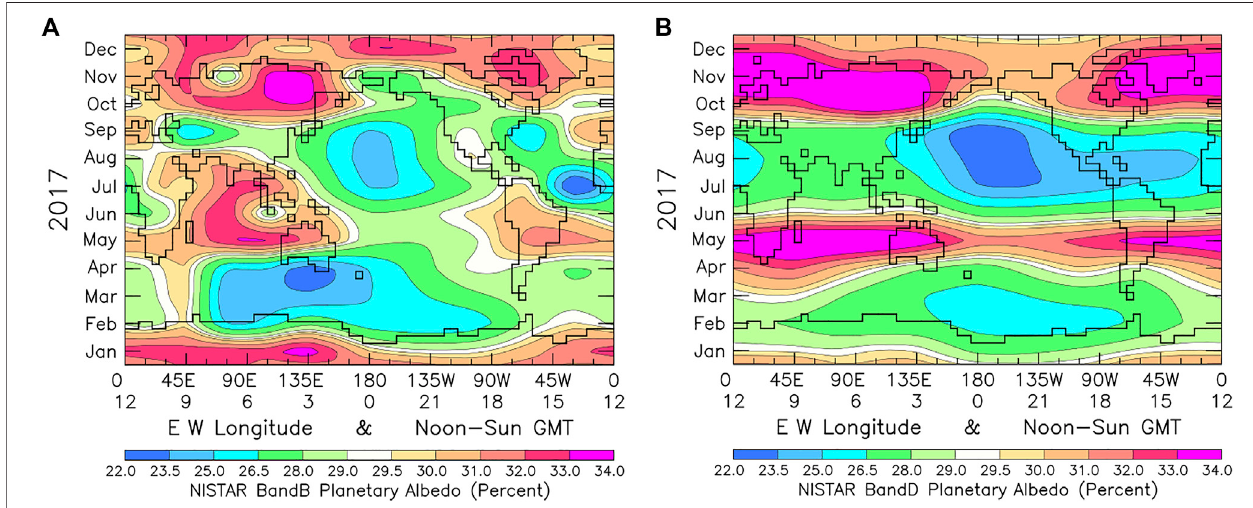
FIGURE 9 | (A) NISTAR solar shortwave (SW) near-backscatter relative radiances for year 2017 from Figure 4B for Band-B (0.2 – 4 μ m), and (B) for photodiode Band-D (0.3 – 1.1 μ m) from Figure 4D , displayed as planetary albedo in Hovmöller format. In both cases, the NISTAR relative radiances are uniformly normalized to the CERESglobalannual-meanof99.1 Wm – 2(Loebetal.(2018),toyieldaglobalannual-meanof29.1percentfortheplanetaryalbedo.IntheHovmöllerformat,theY-scale hasthetimerunningupwardstartingfromJanuaryatthebottom,throughDecemberatthetop.TheX-scalehasthelongituderunningfrom0 ° Elongitudeattheleft and0 ° Wlongitudeattheright.TheX-scalealsoreferencestheGMTofthenoon-timeSun,startingatGMT=0 attheDateLineatthecenter,increasingwestwardtoward the left, as the Earth rotates. A 5 ° × 4 ° GCM world map is included for geographic reference.